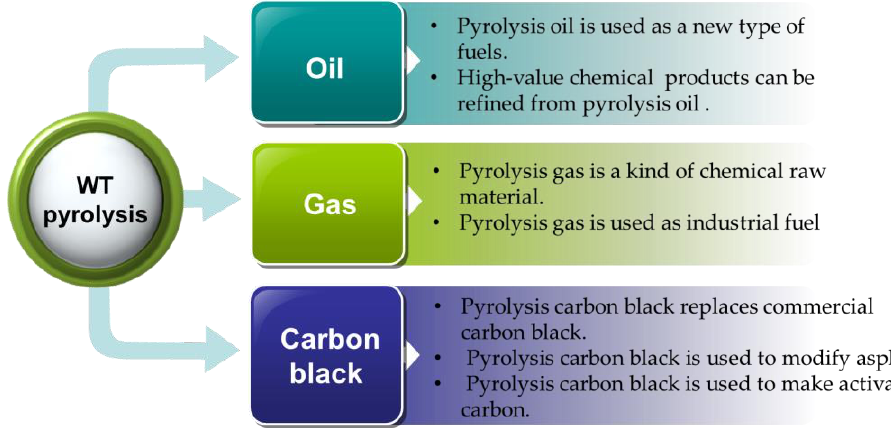
Figure 7. Applications of WT pyrolysis products.